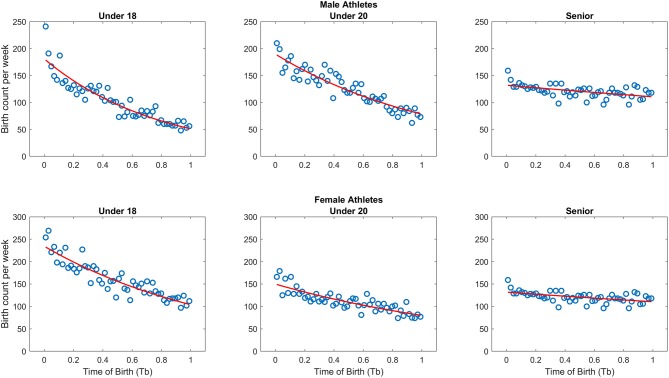
Scatterplot of birthdate frequency by week for Under 18, Under 20, and Senior categories both for male (upper panel) and female athletes (bottom panel). The red line represents the best fit of the Poisson regression.